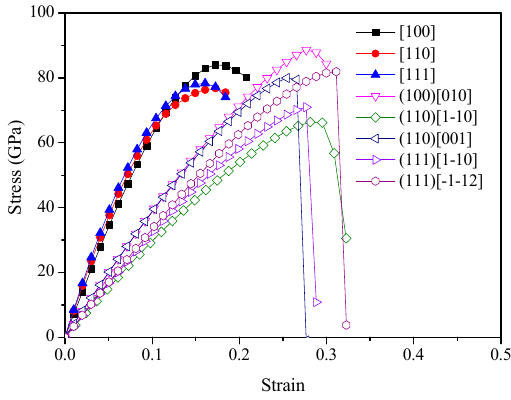
Figure 4. Strain–stress relations for c -C 3 N in various tensile and shear directions.